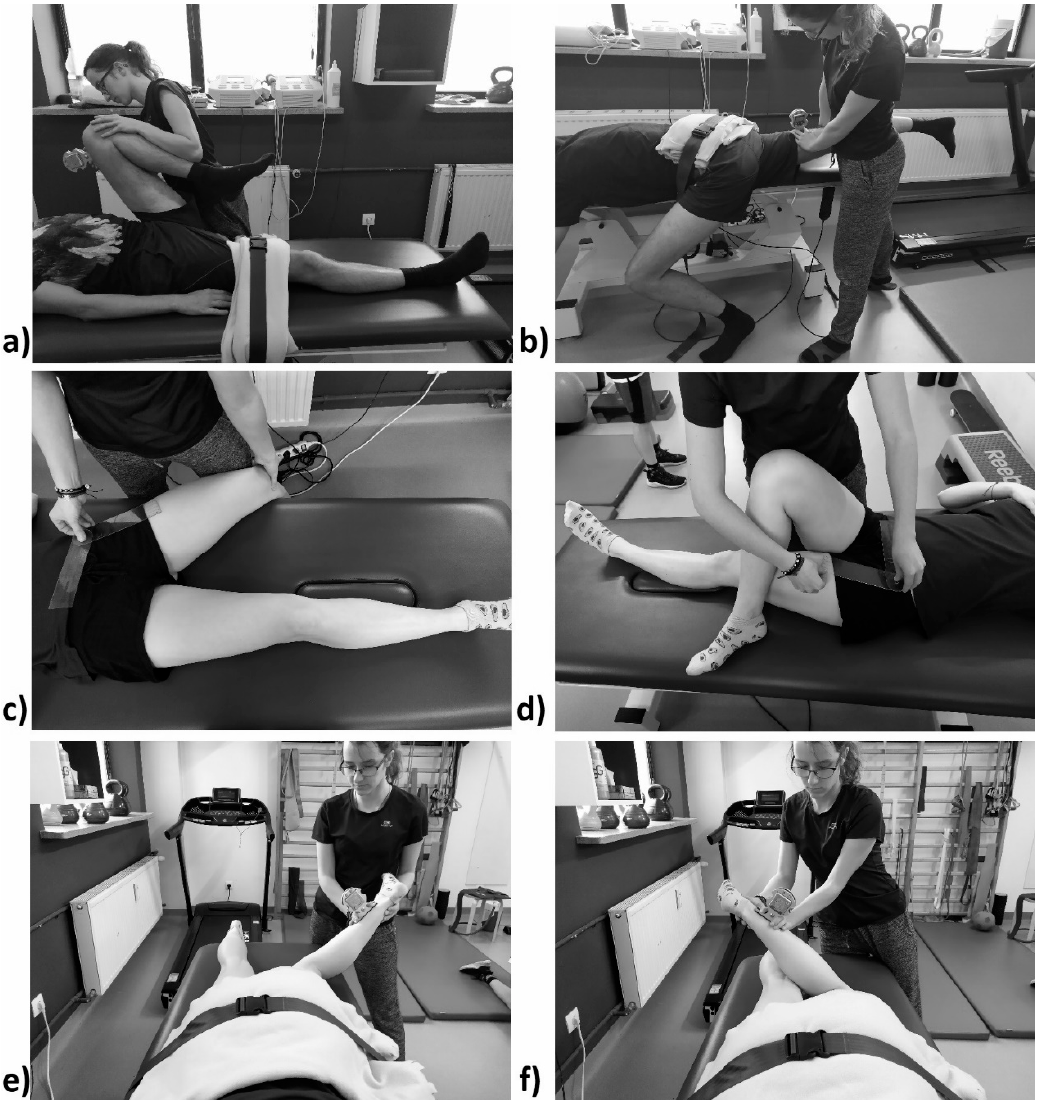
Figure 2. Measurement positions for range of motion: ( a ) flexion; ( b ) extension; ( c ) abduction; ( d ) adduction; ( e ) internal rotation; ( f ) external rotation. Authors’ own materials .